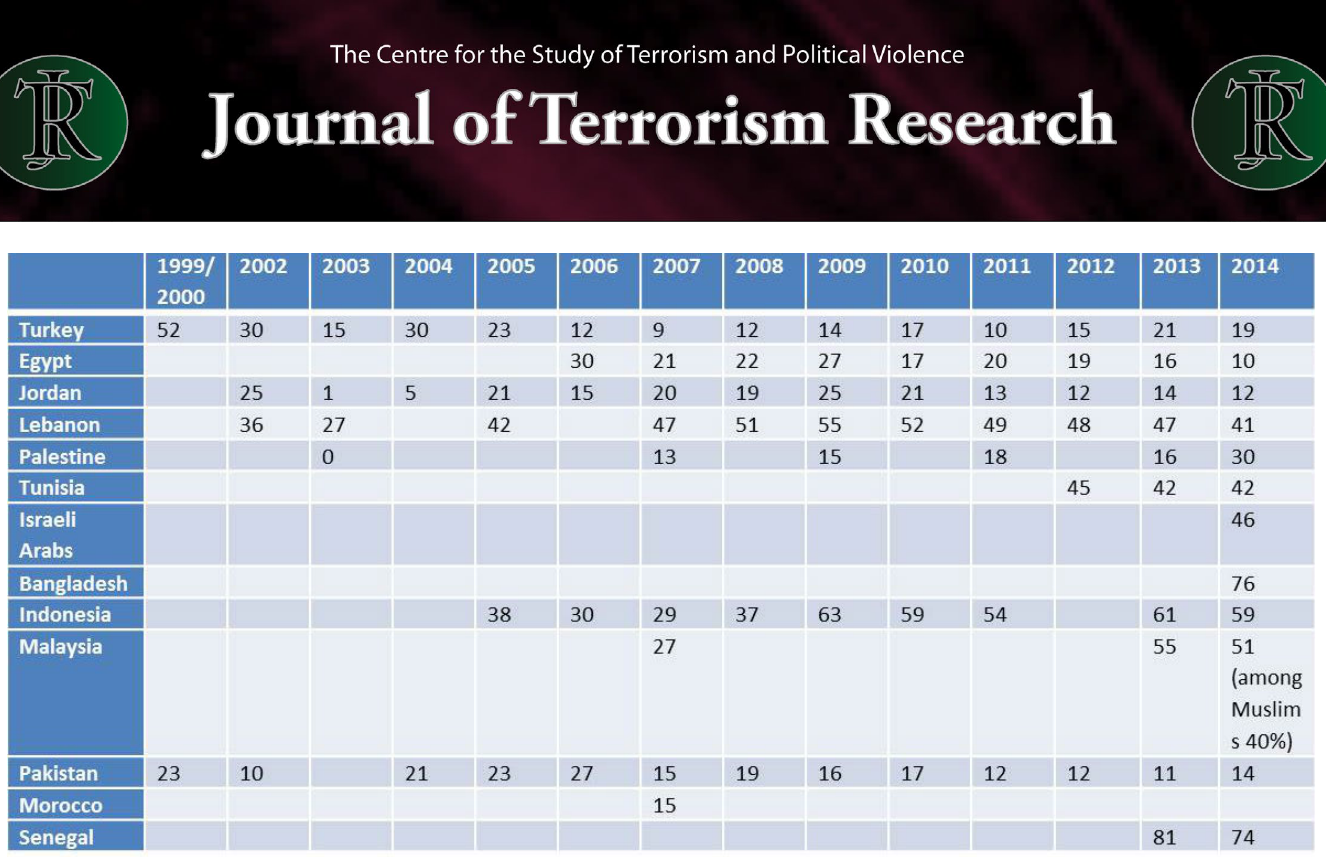
Table 1: Pew Global Attitudes Survey US Favourability Ratings in the Muslim